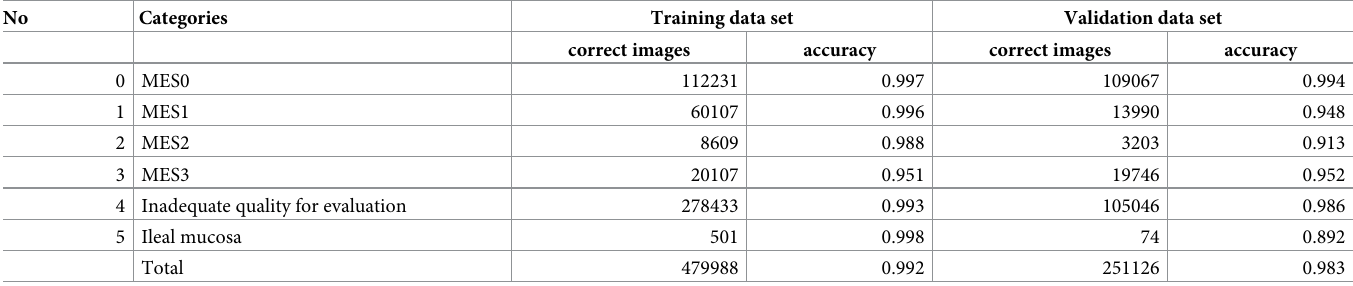
Table 3. Accuracy of the training and test data set. The accuracy for each category is presented next to the number of images. No